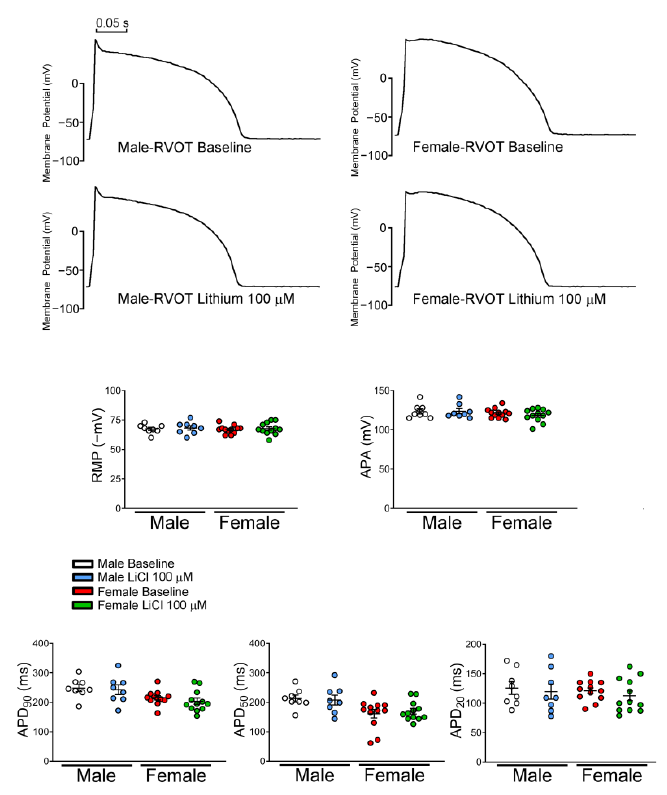
Figure 4. Effects of lithium on the electrophysiologic characteristics of rabbit right ventricular outflow tract (RVOT) cardiomyocytes. Representative tracings and average data of resting membrane potential (RMP), action potential amplitude (APA), and action potential duration at 90%, 50%, and 20% repolarization (APD 90, APD 50 , APD 20 ) in male ( n = 8) and female ( n = 12) RVOT cardiomyocytes before and after lithium (100 µ M) administration. LiCl = lithium chloride.